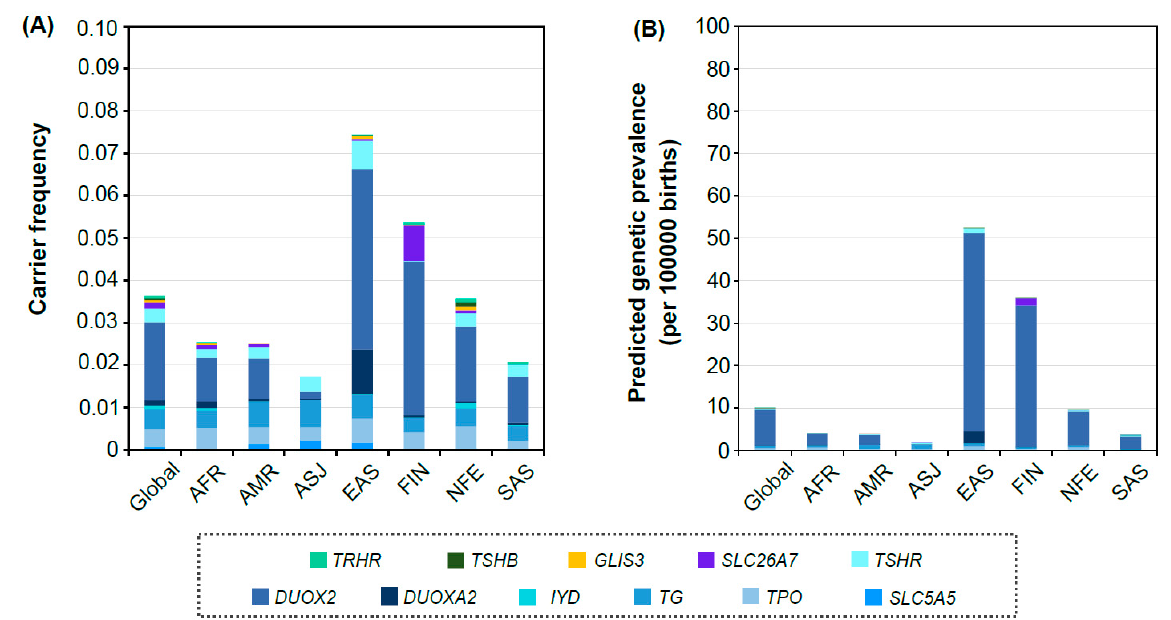
Figure 1. Carrier frequency and predicted genetic prevalence. ( A ) Distribution of carrier frequency in each population. ( B ) Distribution of predicted genetic prevalence in each population.